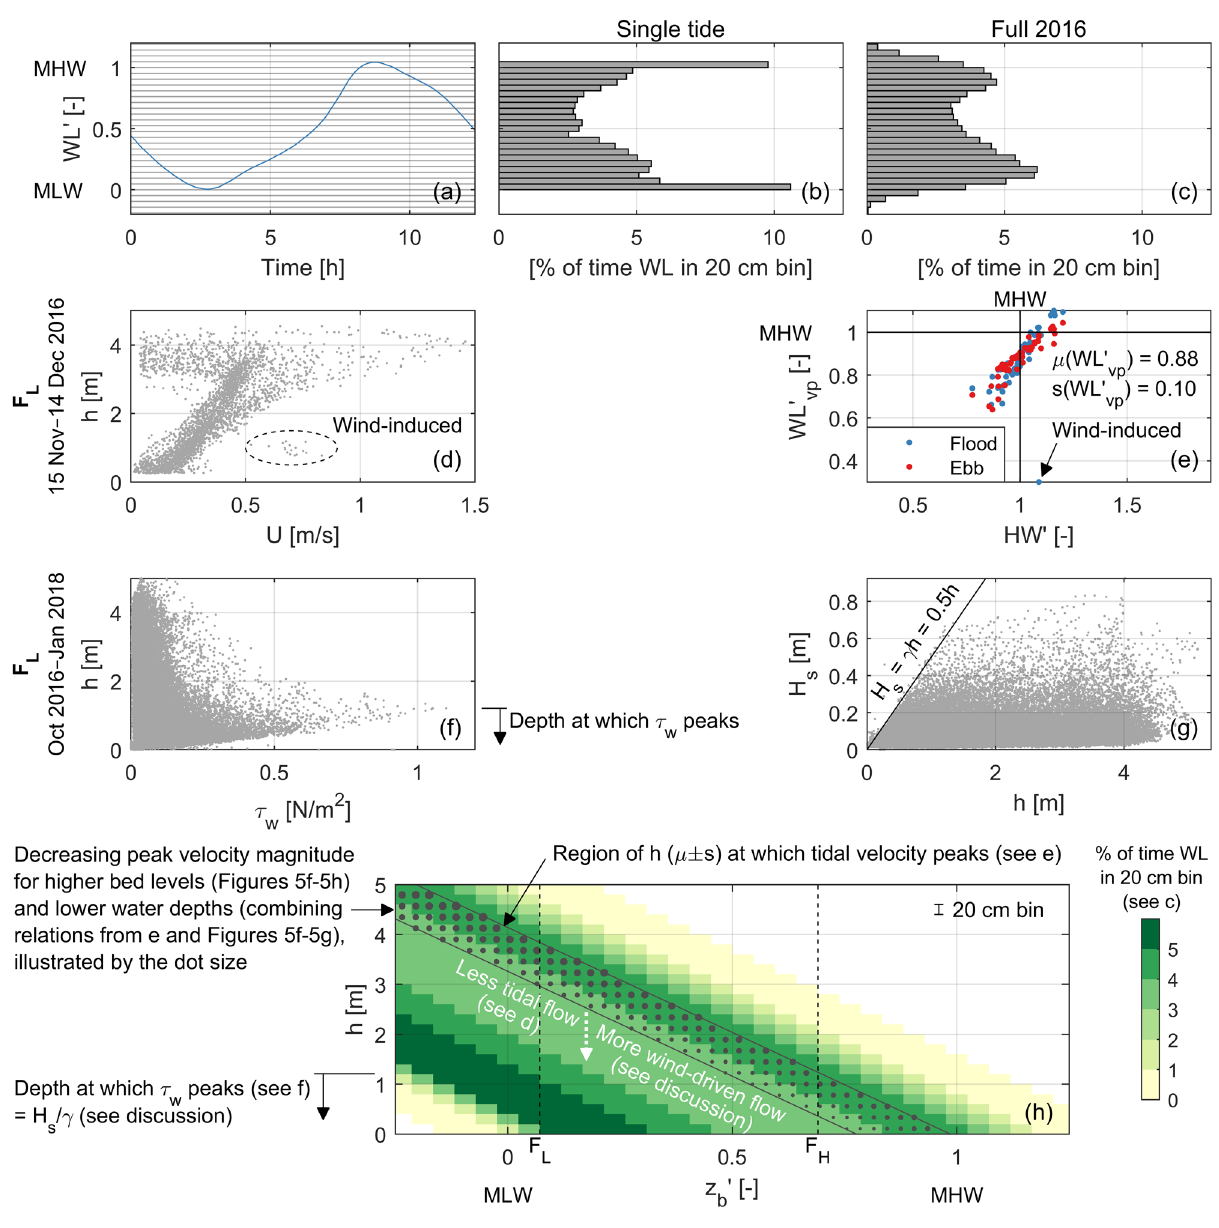
Figure 7. Distributions in hydrodynamic forcing for variations in water depth and bed level. ( a ) Water level time series over a single tidal cycle (29 November 2016) at the Zuidgors intertidal flat (Western Scheldt). The horizontal lines indicate 20 cm bins. ( b ) The corresponding probability distribution of the water level across these bins. ( c ) The probability distribution of the water level over a full year (2016). ( d ) Water depth versus flow velocities at F L (10 min interval). The wind-induced flow during the storm event of Fig. 4 is marked with the ellipse. ( e ) Water levels at which the velocities peak at F L , versus the high water of each tide. The storm of Fig. 4 is indicated. Both axes are scaled along mean low water (MLW; 0) and mean high water (MHW; 1). ( f ) Water depth versus the wave-induced shear stresses at F L (10 min interval). ( g ) Significant wave height versus water depth measured at F L (10 min interval), with the wave-breaking index γ indicated. ( h ) For a range in bed levels (scaled along MLW and MHW) the probability that the water depth is within a certain 20 cm bin is indicated with the colours, using the distribution of ( c ). The diagonal dotted region indicates the water depths at which the tidal velocities peak, using the average and standard deviation of ( e ). The range of depths at which the wave- induced shear stress peaks, based on ( f ), are indicated on the left. The vertical dashed lines show the position of the